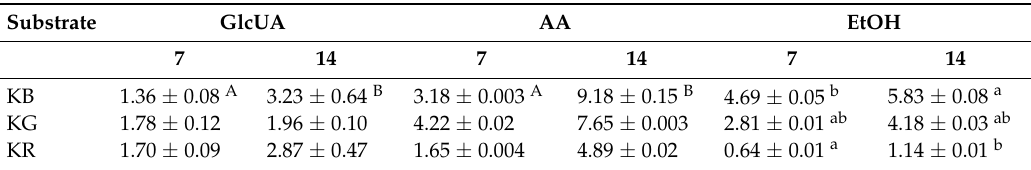
Table 4. Concentration (mg/mL) of glucuronic acid (GlcUA), Acetic acid and ethanol (EtOH) in Kombucha prepared with black tea (KR), green tea (KG), and rooibos tea (KR) at 7 and 14 day of